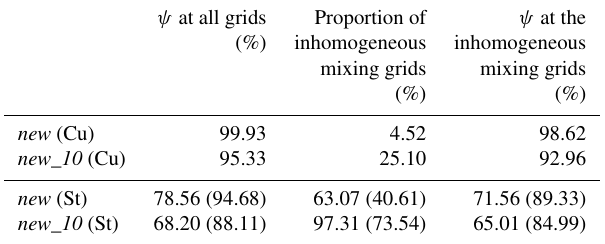
Table 5. Homogeneous mixing degree ( ψ ) at all grid points expe- riencing evaporation, the proportion of inhomogeneous mixing grid points to all grid points experiencing evaporation, and ψ at the inho- mogeneous mixing grid points in the experiments new and new_10 (Table 1) for the cumulus (Cu) and stratocumulus (St) cases. The numbers in and out of the parentheses are the results at the mature and dissipation stages in the stratocumulus (St) case, respectively. The experiments are detailed in Table